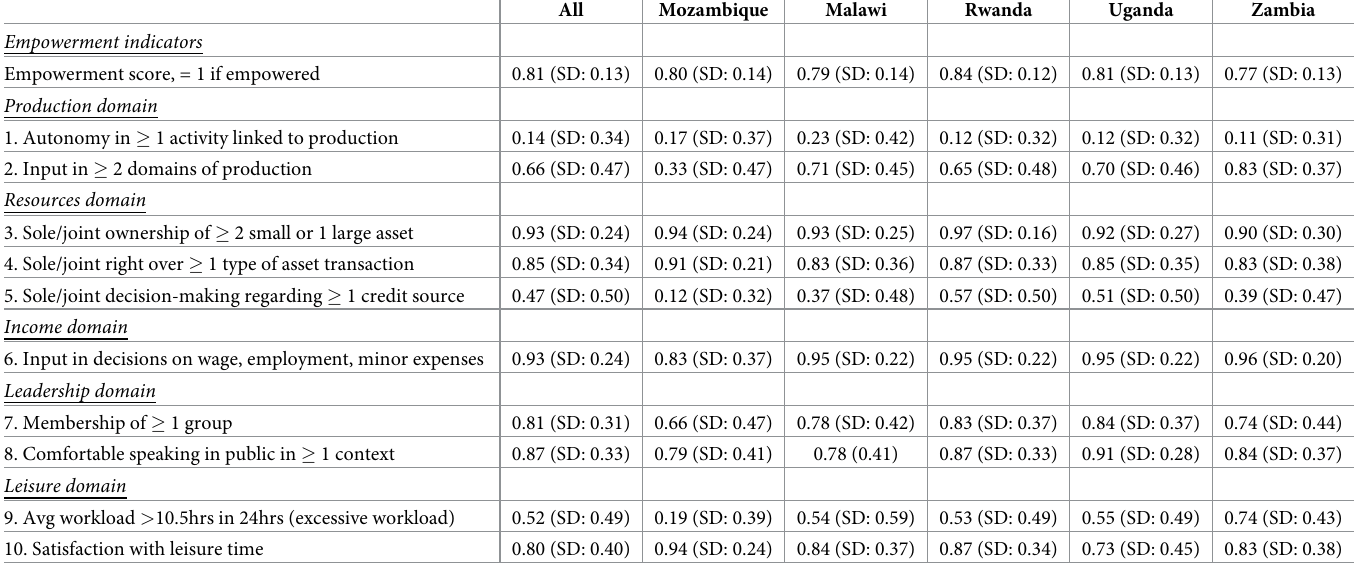
Table 3. Descriptive statistics of the 10 WEAI indicators. All Mozambique Malawi Rwanda Uganda